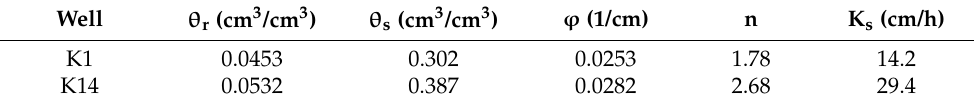
Figure 3. The measured and simulated data of soil moisture at ( a ) 20 cm depth and ( b ) 100 cm depth for K1, and ( c ) 20 cm depth and ( d ) 40 cm depth for K14. Table 3. Simulated soil hydraulic parameters for K1 and K14.